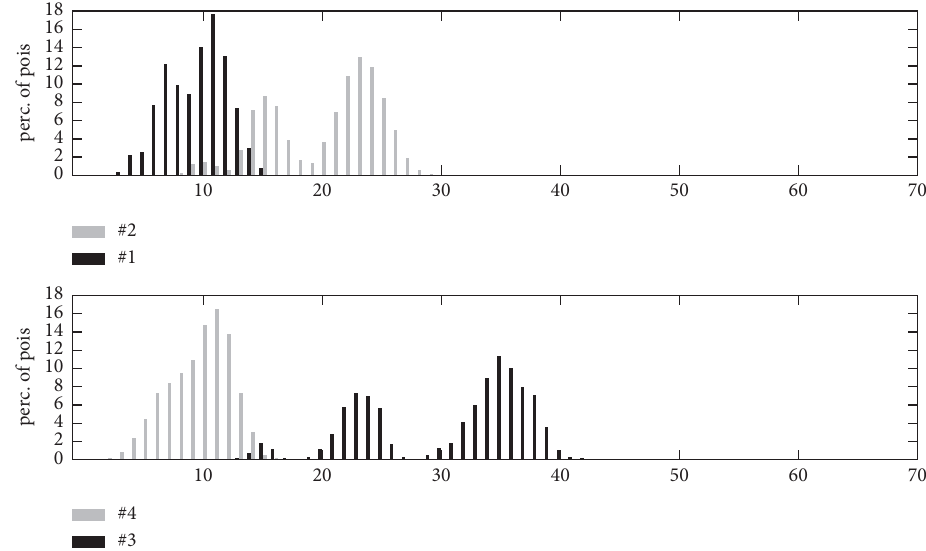
Figure 12: Percentage numbers of POIs covered by diferent numbers of sensors for the benchmark given in [7,